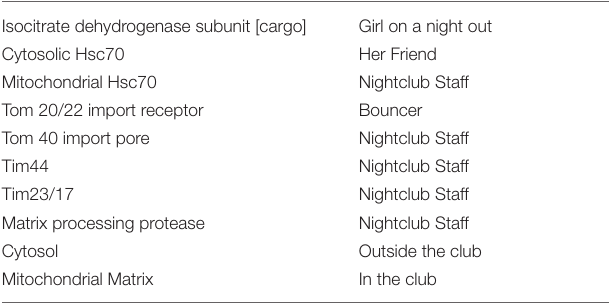
The overall concept and the analogies made between the proteins/protein complexes/subcellular locations and the characters/locations in the role-play are indicated. The video of the role-play for topic 1 employs elaborate analogies and can be viewed on YouTube at the following link: https://youtu.be/oxOBMQhVtT0.